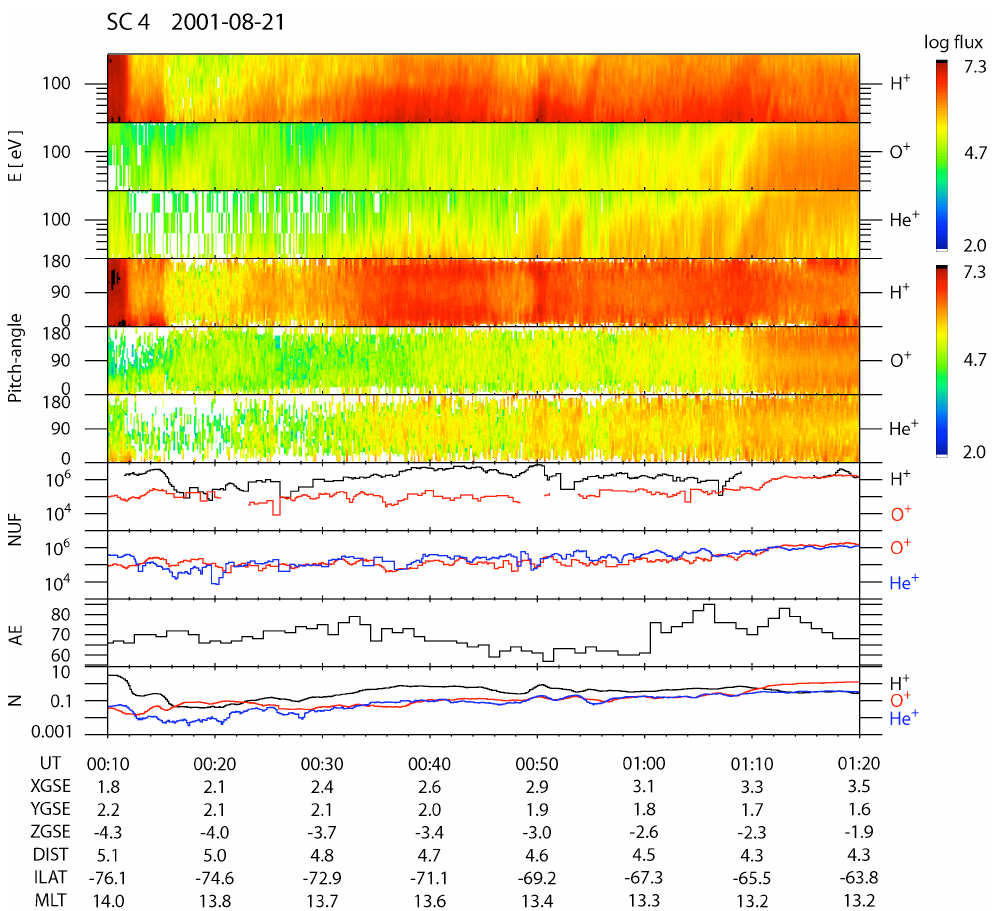
Figure 4: Energy-time spectrograms and differential fluxes in [(cm 2 s sr) -1 ], pitch-angle Fig. 4. Energy-time spectrograms, pitch-angle distributions [(cm 2 ssrkeV) − 1 ], net upgoing fluxes (NUF) in [cm − 2 s − 1 ], AE in [nT] and density plot in [cm − 3 ] in the energy range of 40eV to 200eV (low energy) for H + , O + and He + during the period from 00:10UT through 01:20UT, on 21 August distributions, net upgoing fluxes (NUF) in [cm -2 s -1 ], AE in [nT] and density plot in [cm -3 ] in the energy range of 40 eV to 200 eV (low energy) for H + , O + and He + during the period from 00:10 UT through 01:20 UT, on August 21, 2001.